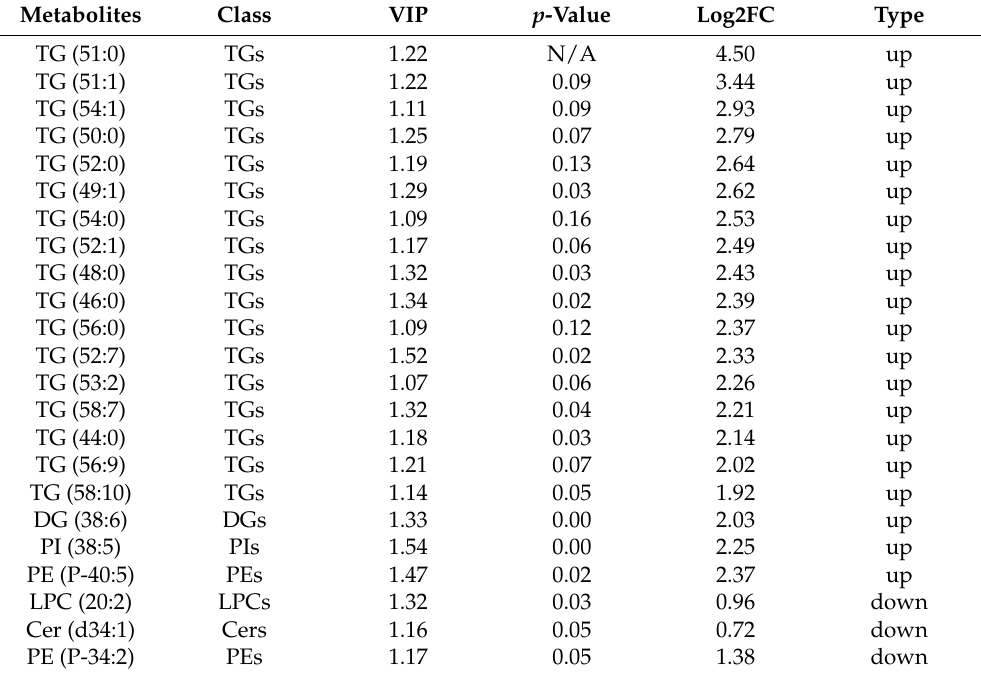
Table 9. Top 20 differential up-regulated and down-regulated metabolites.